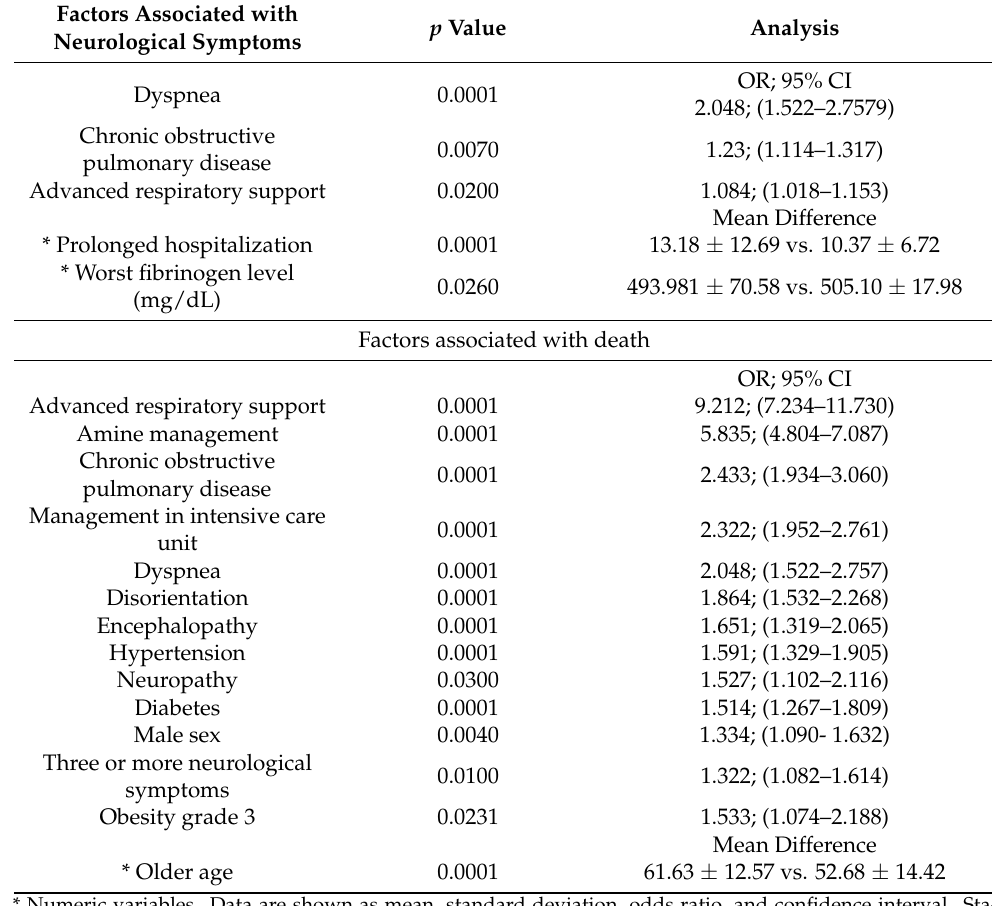
Table 6. Profile of factors associated with neurological symptoms and